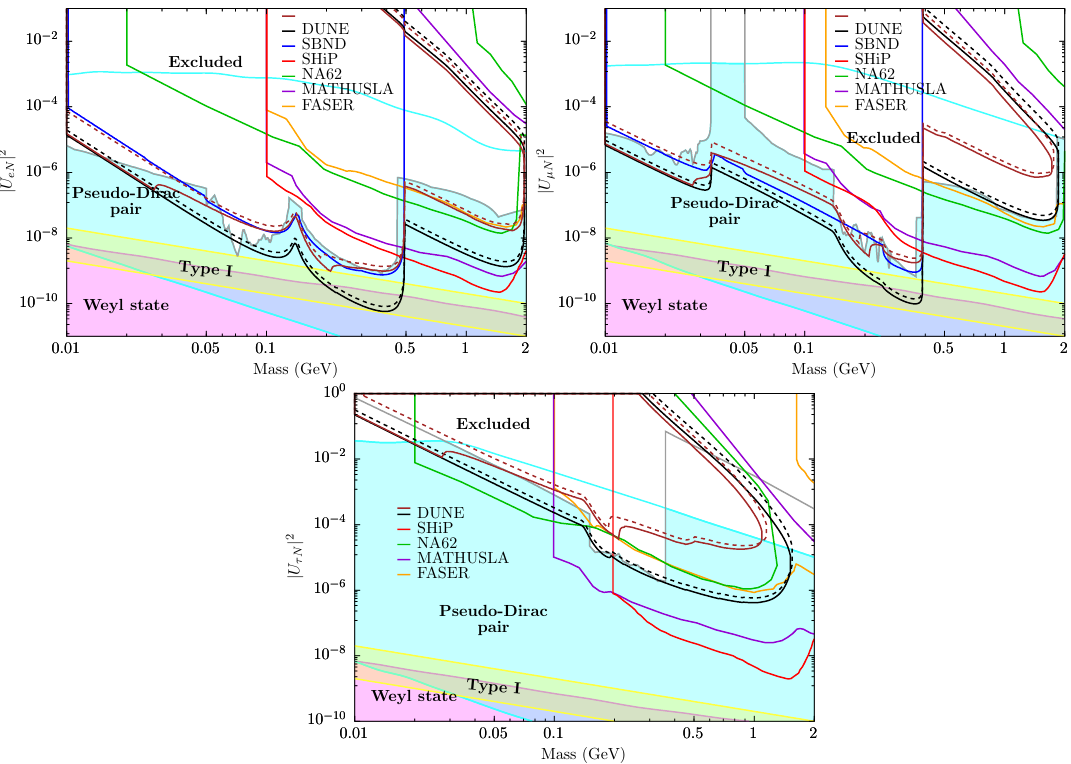
Figure 8 . The 90 % C.L. sensitivity regions for dominant mixings j U eN j 2 (top left), j U (cid:22)N j 2 (top right), and j U (cid:28)N j 2 (bottom) are presented combining results for channels with good discovery prospects (see text). The study is performed for Majorana neutrinos (solid) and Dirac neutri- nos (dashed), in the case of no background (black) and after the background analysis (brown). The region excluded by experimental constraints (grey) is obtained by combining the results from PS191 [60, 61], peak searches [55{59], CHARM [63], NuTeV [65], DELPHI [64], and T2K [77], with the lines reinterpreted for Majorana neutrinos (see [154]). The sensitivity for DUNE ND (black) is compared to the predictions of future experiments, SBN [78] (blue), SHiP [129] (red), NA62 [119] (green), MATHUSLA [122] (purple), and FASER [124] with 1 m radius (orange). The shaded